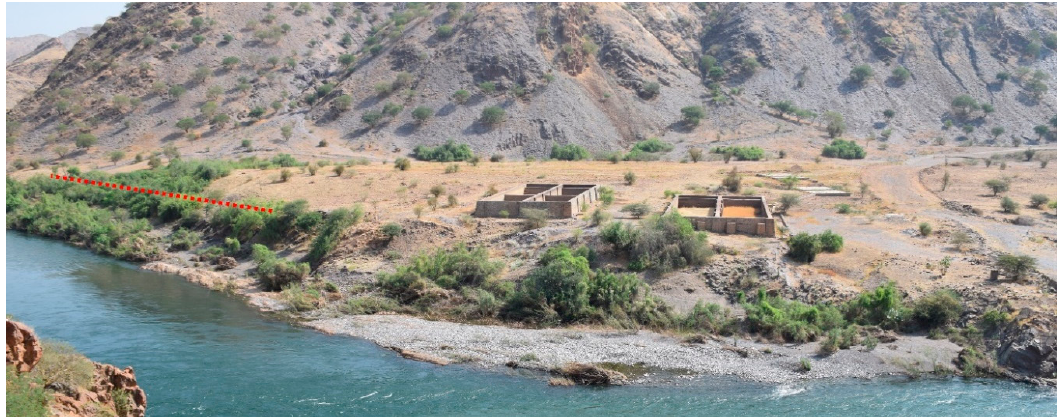
Figure 4. The Tekeze River has incised at least 4 m. Evidence for this was provided by a river terrace (dotted red line) and deep lateral gullies that were dated “pre-dam” and “post-dam” respectively by local inhabitants during field interviews (Photo: 15 October 2018).